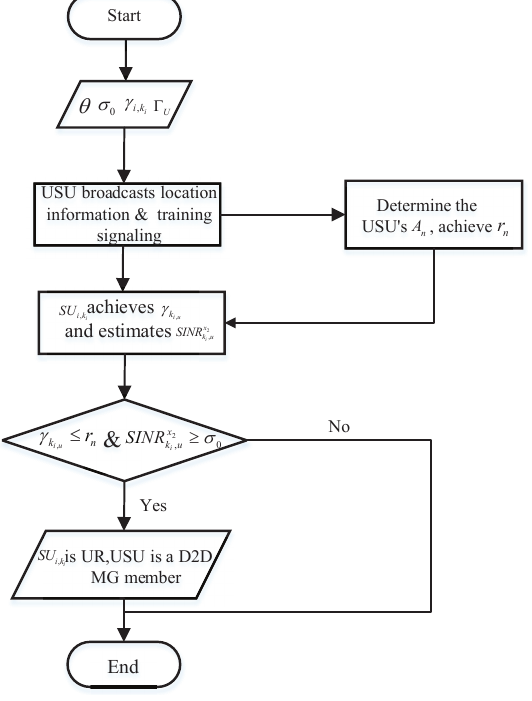
Figure 3. The flow chart of